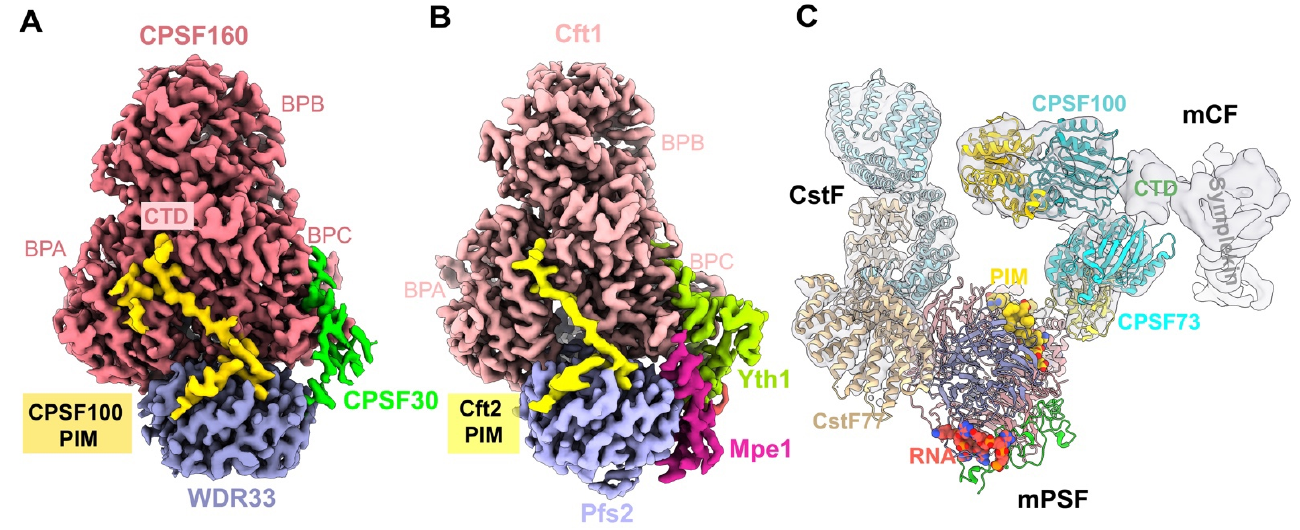
Figure 4. Overall architecture of the human canonical pre ‐ mRNA 3 ′‐ end processing machinery. ( A ) Cryo ‐ EM reconstruction of the human mPSF in complex with the CPSF100 PIM (in gold). ( B ) Cryo ‐ EM reconstruction of the yeast polymerase module in complex with the Cft2 PIM (in yellow). ( C ) A model for the mPSF ‐ mCF ‐ CstF complex of the human canonical machinery, which is produced by overlaying the structures of the mPSF ‐ mCF and mPSF ‐ CstF complexes. The view is similar to that in Figure 2. mPSF module is colored as in panel A, and its view is from the bottom. The PAS RNA and PIM are shown as ball ‐ and ‐ stick models. The region of symplekin for CstF64 binding is disor ‐ dered. The symplekin CTD is labeled in panel C. CstF77 is in blue and beige.